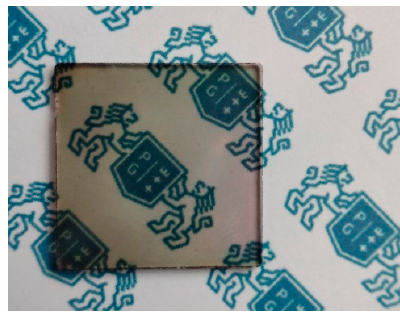
◦ C with a 2000 ppm [B]/[C]